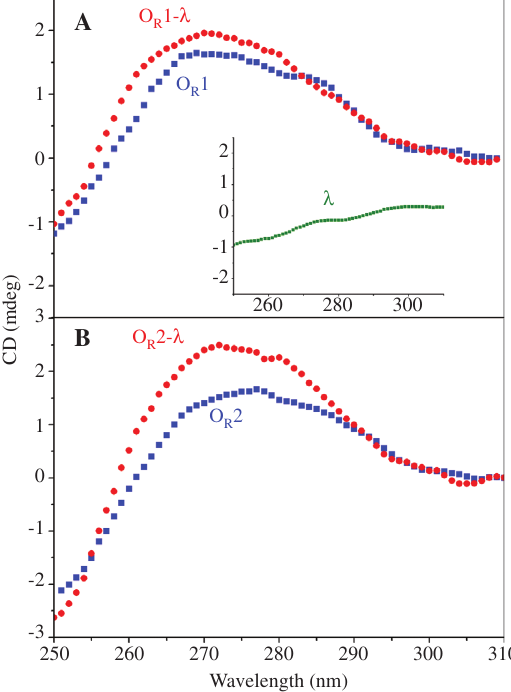
Figure 14 Circular dichroism (CD) spectroscopy of operators and their complexes with repressor protein. 1 DNA in presence and in absence of (A) Ellipticity (mdeg) of O R λ -repressor protein. The inset image represents the CD spectrum of λ -repressor protein. (B) Depicts the optical rotation (mdeg) of O 2 DNA R in presence and in absence of λ -repressor protein. Upon complexation with protein, the characteristic peak of DNA around 270 nm is blue shifted. No significant wavelength shift was observed in case of O 1. R